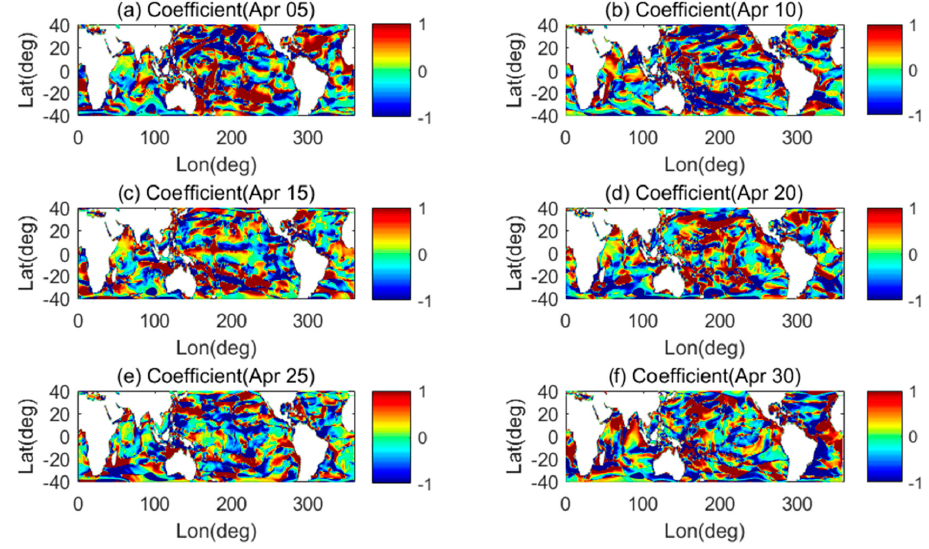
Figure 8. Distribution of estimated coefficients in April 2017.